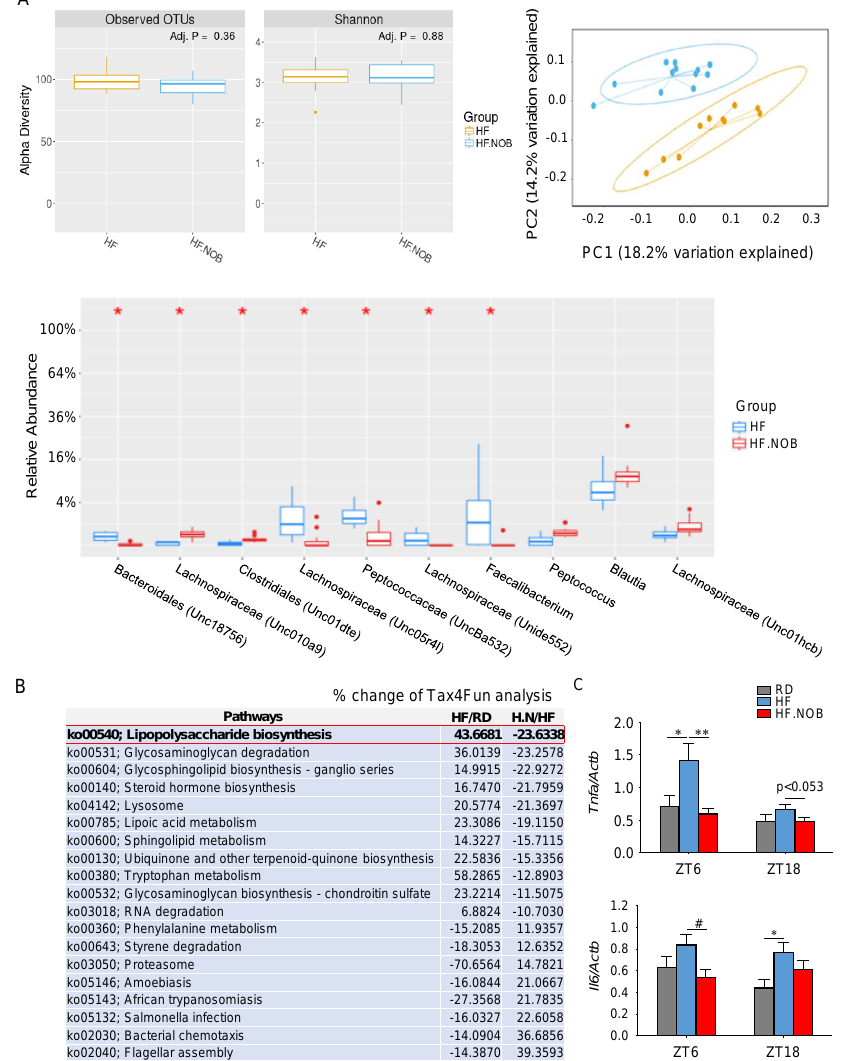
Figure 5. Nobiletin (NOB) remodels gut microbiota and protects the liver from inflammatory damage. ( A ) Microbial 16S rRNA sequencing showing the taxa abundance distribution at the genus level. Left top: alpha diversity box plots; right top: Principal component analysis. P value: 0.001; R-squared: 0.142; F-statistic: 3.3. Yellow: HF; blue: HF.NOB. Bottom: top 10 taxa abundance box plot. Panels indicate the comparison between HF and HF.NOB groups. ( n = 10–12). ( B ) Pathway analysis using 16S sequencing data. Data indicate the comparison between HF versus RD and HF.NOB (H.N) vs HF groups. ( n = 10–12). ( C ) Inflammatory cytokine gene expression levels in the liver were analyzed by qPCR ( n = 7–11). RD: regular diet; HF: high-fat diet; HF.NOB: high-fat diet with 0.1% NOB. * p < 0.05, ** p < 0.01, One-Way ANOVA; # p < 0.05, t-test. Bar graphs represent the Mean ±